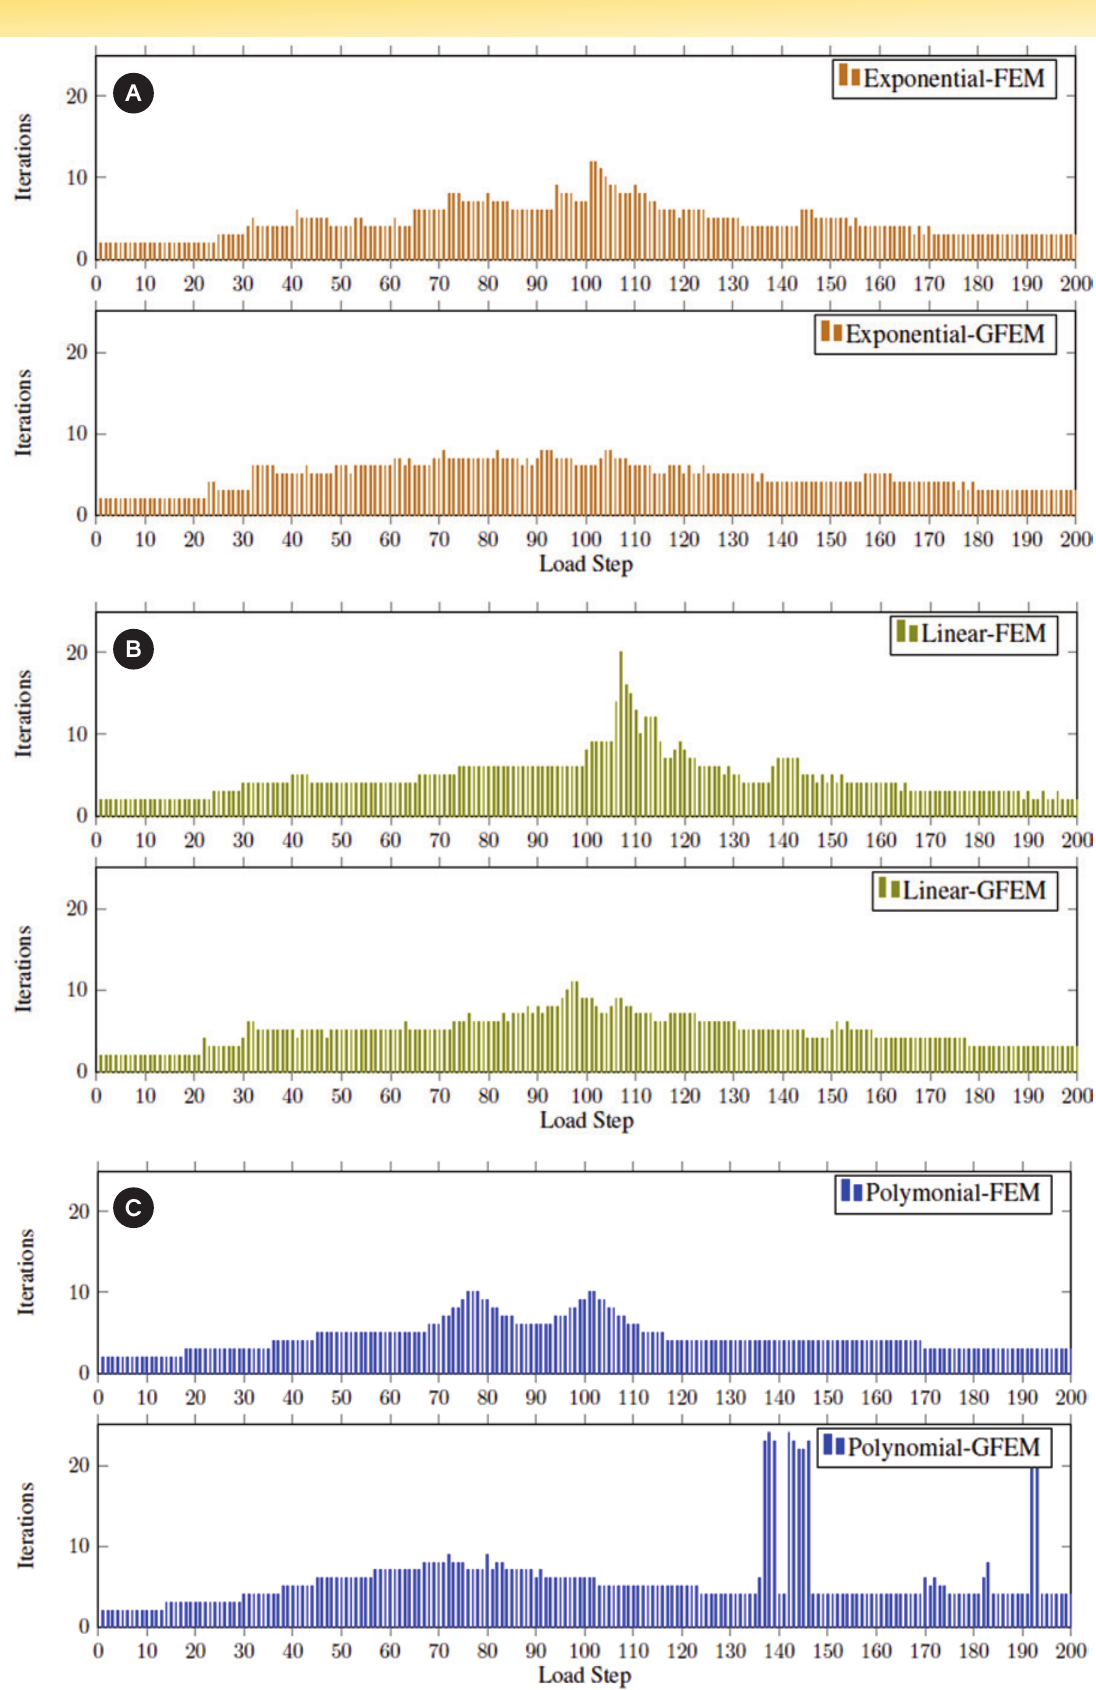
Number of iterations per load step: (a) Exponential; (b) Linear and (c) Polynomial damage laws to FEM versus GFEM